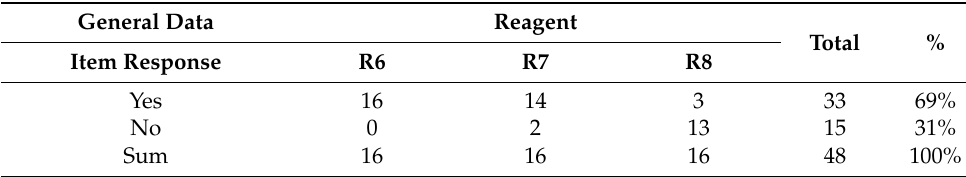
Table 8. Frequency analysis of R6 to R8